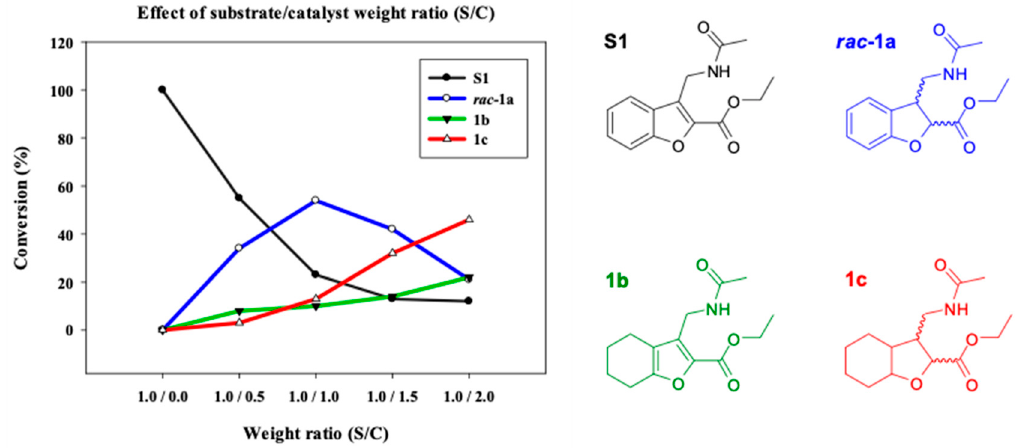
Figure 1. Variation in the hydrogenated products obtained (%) from compound 1 at 24 h due to the effect of the S/C ratio (entries 1–4, Table 2).